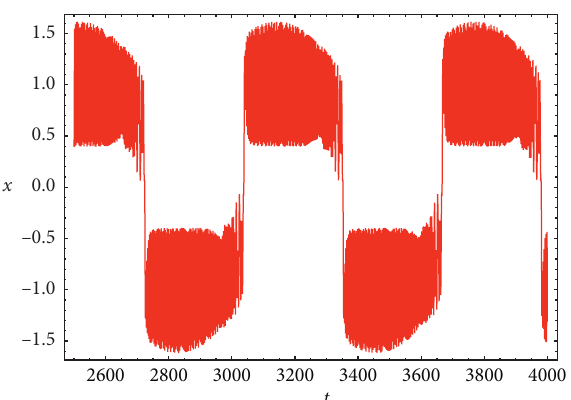
� 200 ω , 1 2 � 2 , ω � 0 . 01 , 1 2